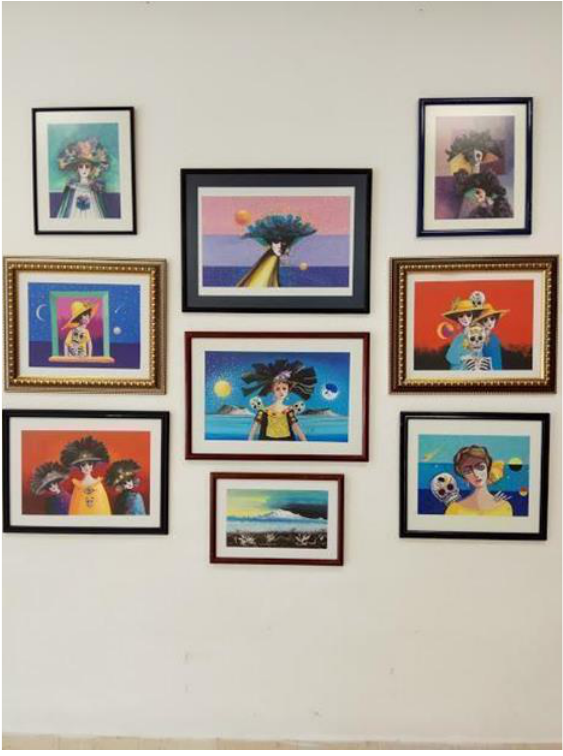
Figure 8 Exhibition of paintings by José Luís González Cedillo arranged for his annual day of the dead (Dia de los Muertos), October/November 2017. Courtesy: José Sherwood